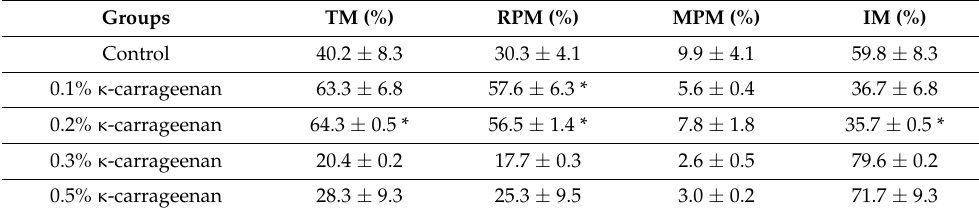
Table 2. Effect of different κ -carrageenan concentrations in egg yolk-free extender on the motility of canine sperm following freezing-thawing.